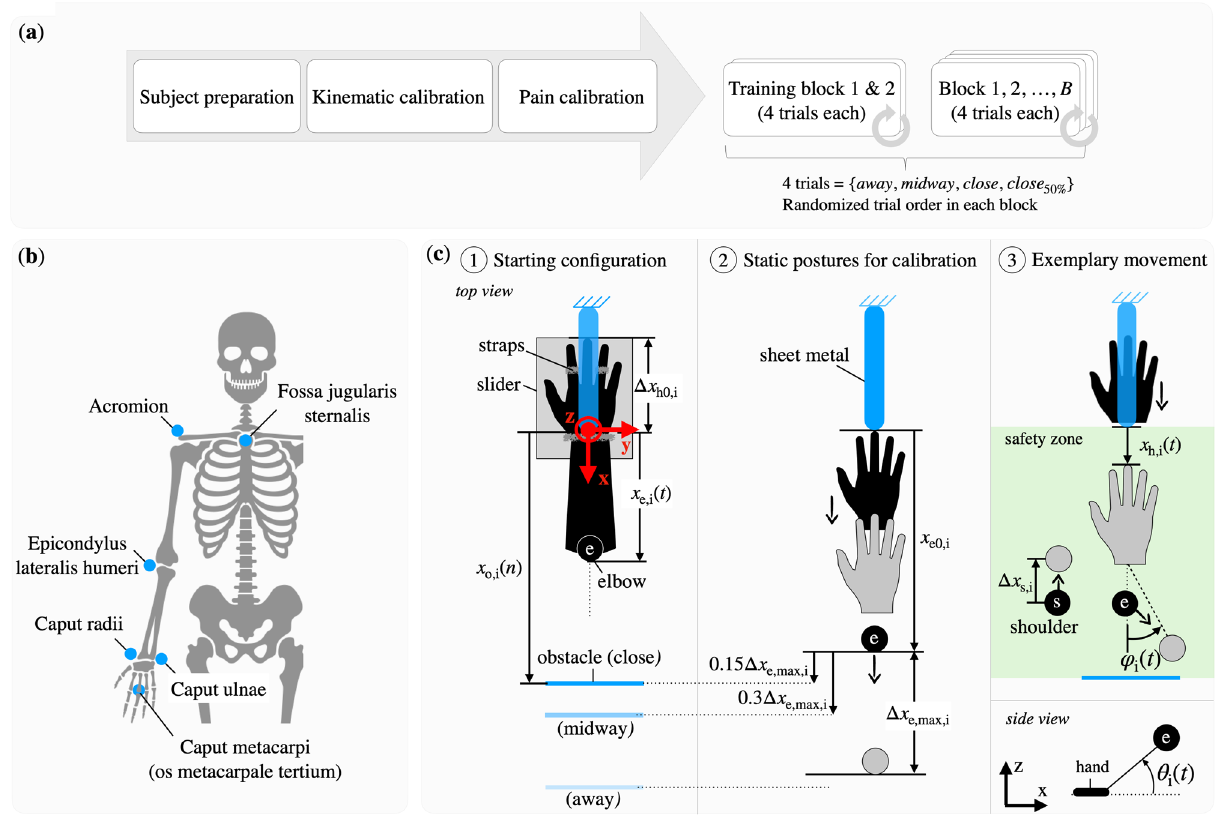
Figure 6. ( a ) Experimental protocol sequence. ( b ) Marker placement. ( c ) Measurements for data analysis of subject i